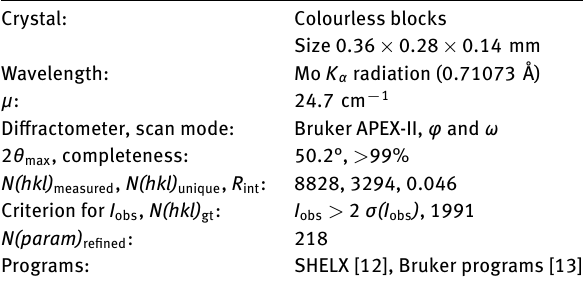
Table 2: Fractional atomic coordinates and isotropic or